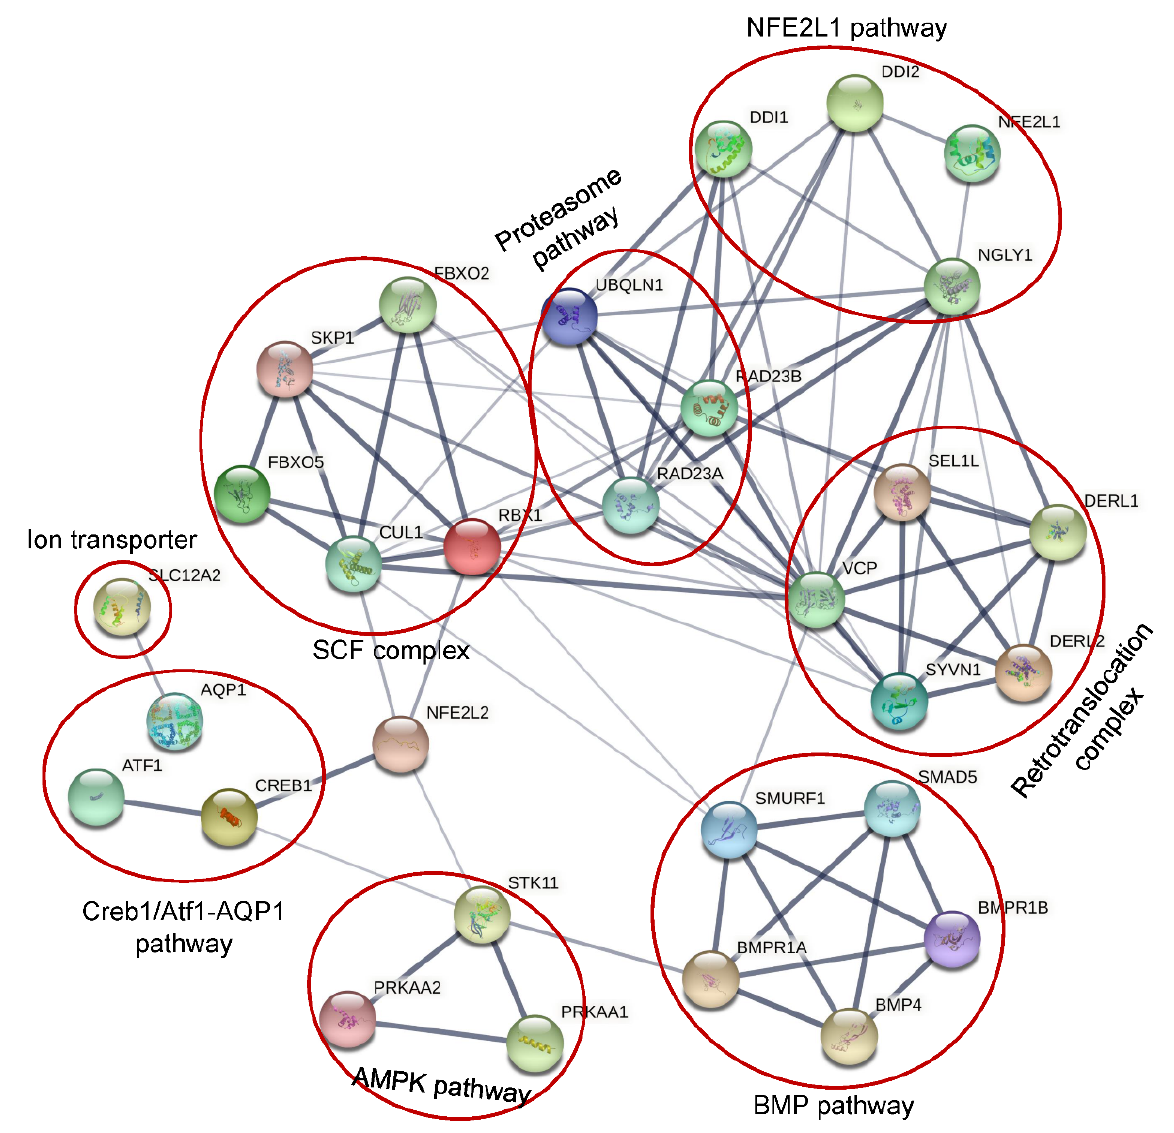
Figure 8. Protein network involving NLGY1 by STRING.